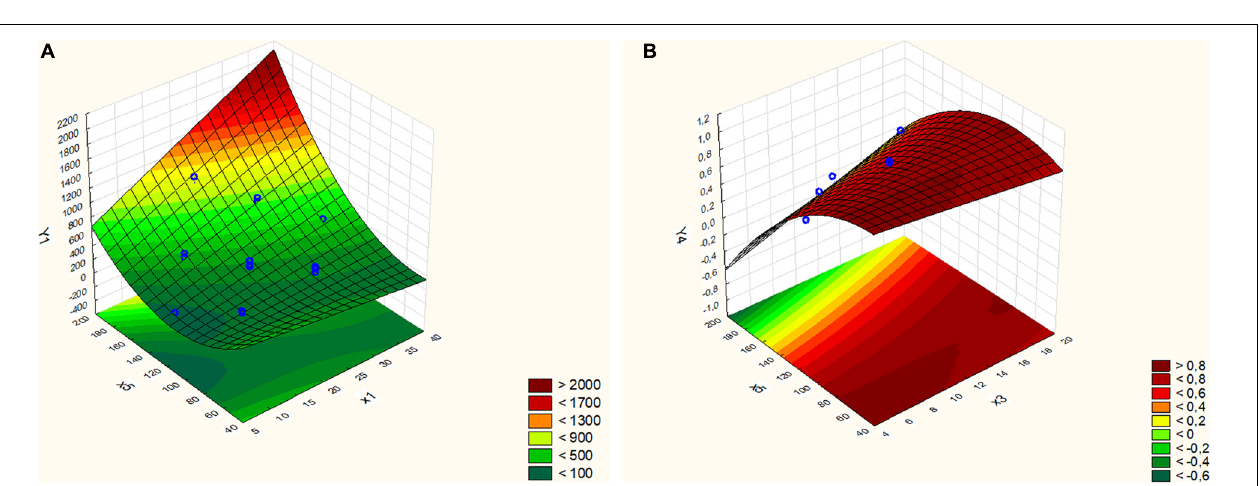
FIGURE 6 | (A) Pareto chart with significant standardized effects with respect to Y1 and (B) a chart describing the relationship between observed and predicted model values with respect to Y1.